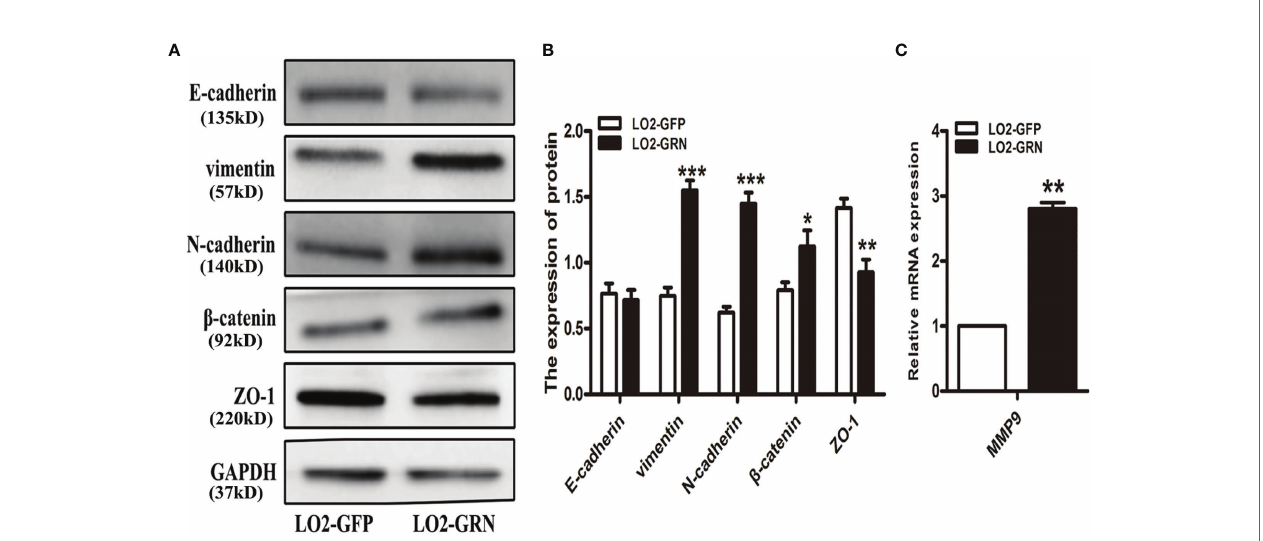
FIGURE 5 | Effects of Cs GRN overexpression on the regulation of EMT-related gene expression. (A) The expression of vimentin, N-cadherin, b -catenin, and ZO-1 was detected in Cs GRN-overexpressed LO2 cells by Western blot. (B) The protein quanti fi cation was measured by Image J software. (C) The relative mRNA expression of matrix metalloproteinases (MMPs) was detected in transfected LO2 cells. * P < 0.05 versus control group, ** P < 0.01 versus control group, *** P < 0.001 versus control group.